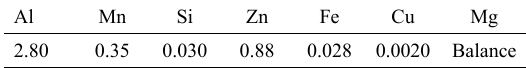
Table 1. AZ31B Mg composition (in weight %).